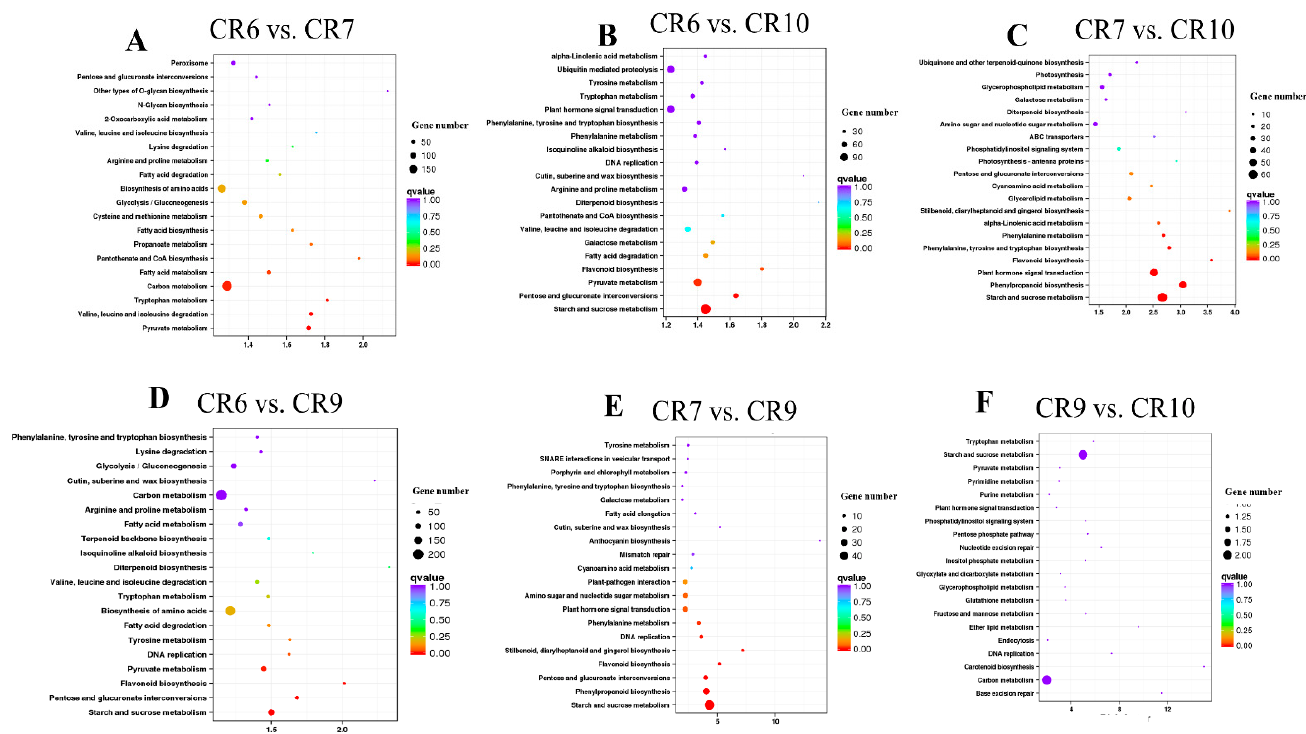
Figure 6. KEGG enrichment of six developmental stage comparisons. ( A – F ) Results of KEGG enrichment of differential genes in comparison groups (CR6 vs. CR7, CR6 vs. CR10, CR7 vs. CR10, CR6 vs. CR9, CR7 vs. CR9, and CR9 vs. CR10). The ordinate is the pathway name while the abscissa represents the rich factor. The size of the dot indicates the number of DEGs in the pathway and the color of the dot corresponds to different q-value ranges.